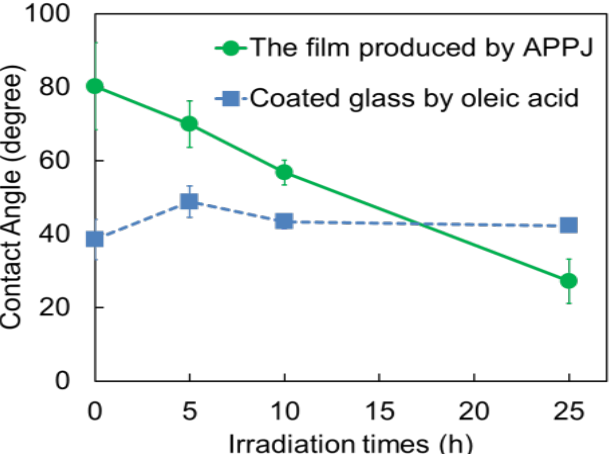
Figure 7. Photocatalytic decomposition of oleic acid using bare glass and TiO 2 thin films.